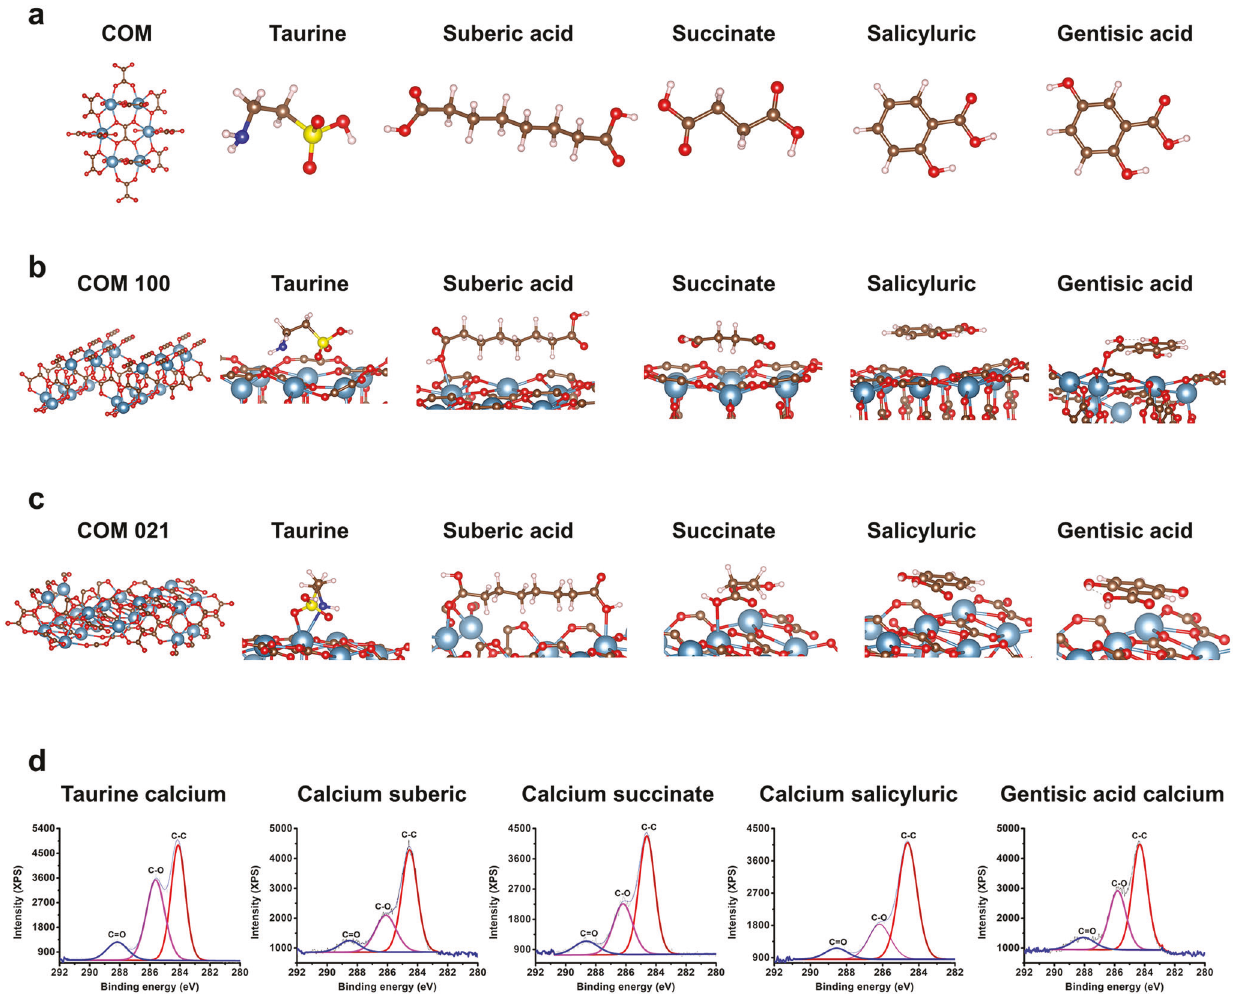
Fig. 3 Binding energy of the modi fi ers on the COM surface and Ca 2 + . a The optimized structures of COM, taurine, suberic acid, succinic, salicyluric and gentisic acids. b , c Optimized structures of the molecules on the COM (100) and COM (021) surface, with the light-pink, light- blue, brown, blue, yellow and red balls denoting the H, Ca, C, N, S and O atoms, respectively. d X-ray photoelectron spectra (XPS) of taurine, suberic acid, succinic, salicyluric and gentisic acids adsorbed to Ca 2 + . The fi tted peaks in blue, pink and red correspond to the C1s peaks of C = O, C – O and C – C,